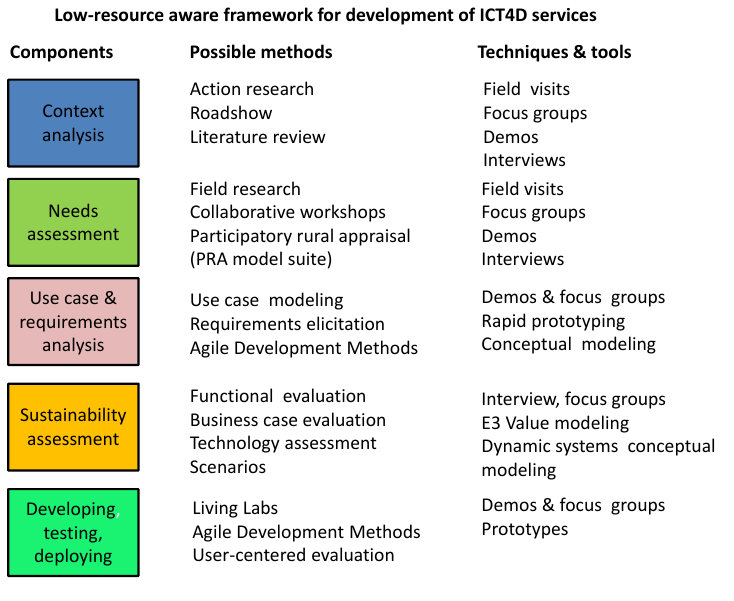
Figure 1. Framework for ICT4D Service Development with five components, with related methods and